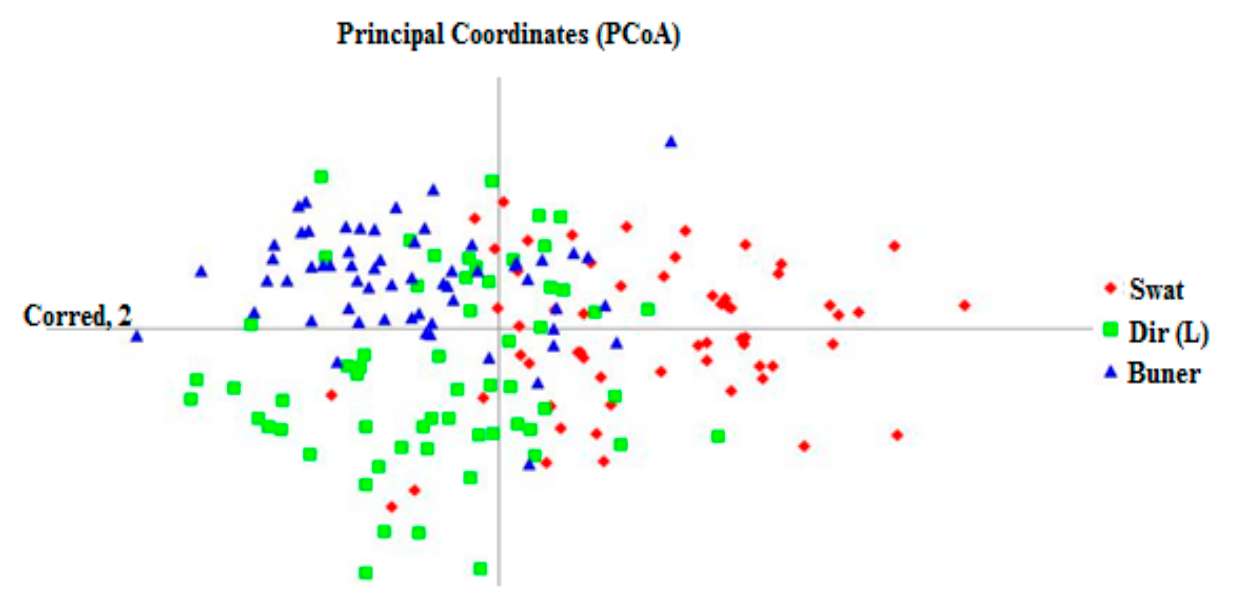
Figure 7. Principle coordinate analysis (PCoA) plots to show the clusters among 180 Z. nummularia genotypes.